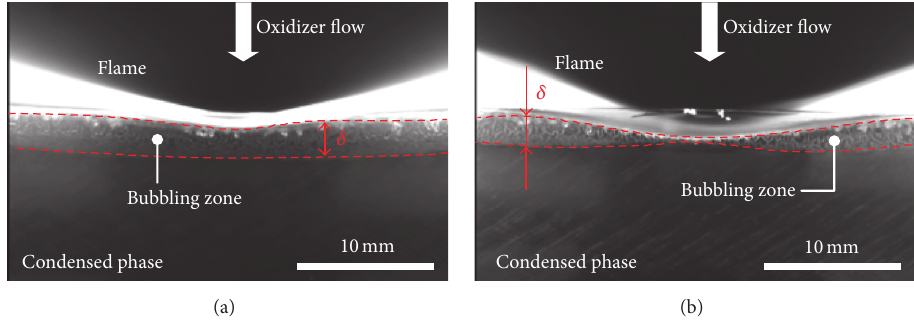
Figure 6: Photographs of PMMA burning for (a) V = 1.9 m/s and (b) 5.6 m/s. The oxygen concentration was 50 vol.%.